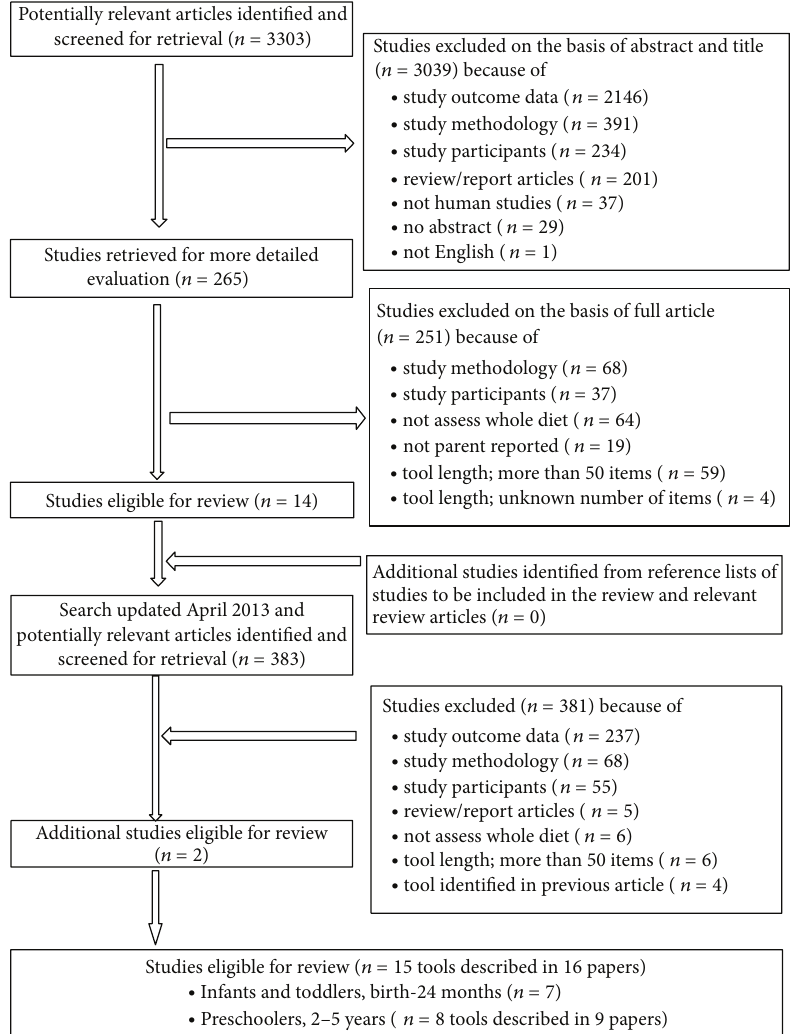
Figure 1: Quorom statement flow diagram. Studies assessing whole-of-diet intake of infants and toddlers and pre-schoolers using a short assessment